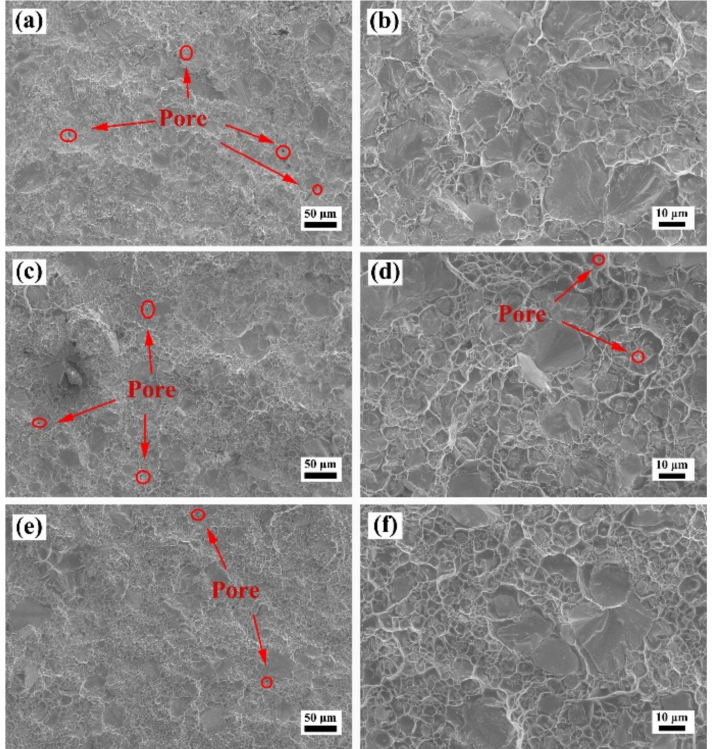
Figure 11. SEM images of the fracture surface of the ( a , b ) WM–G–10Cu, ( c , d ) WM–G–15Cu, and ( e , f ) WM–G–20Cu composites after bending